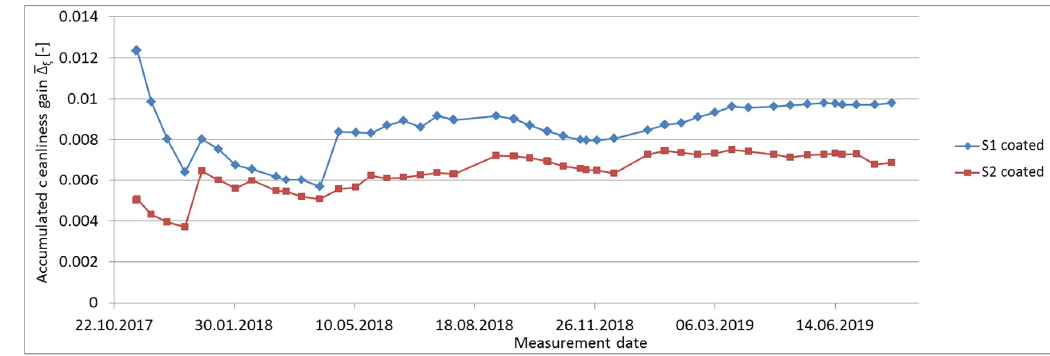
Figure 5. Accumulated cleanliness gain for both structures.